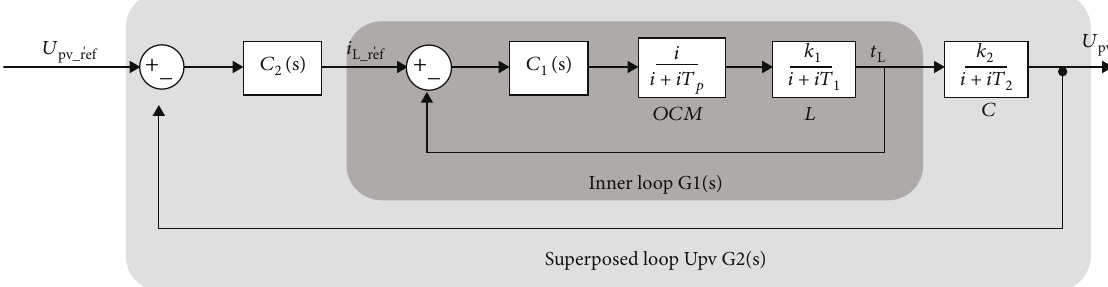
Figure 6: The simpli fi ed block diagram of the process.